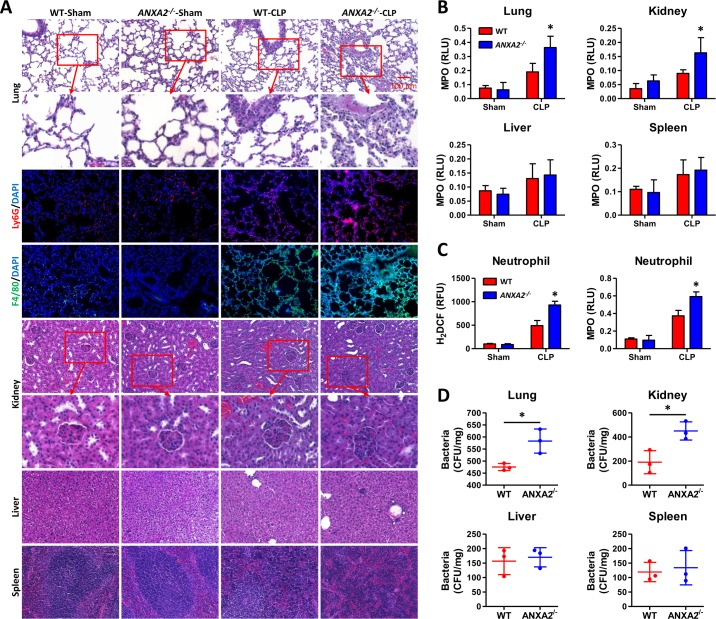
Distant organ injuries in mice with polymicrobial sepsis.(A) Mice were subjected to CLP procedures to induce polymicrobial sepsis. At 24 h post-CLP, lung, kidney, liver and spleen tissues were sectioned for H&E staining and the lung was immunostained with Ly6G or F4/80. (B) MPO determined in homogenates from above-indicated tissues. (C) 24 h after CLP, neutrophils were isolated from blood for H2DCF and MPO assays after 1 h incubation. (D) CFUs evaluated with the lung and kidney as above (n = 3, means±SD). A, data are representative of three independent experiments. B, C, means+SD from triplicate. One-way ANOVA (Tukey’s post hoc); *, p<0.05. Scale bar = 5 μm.